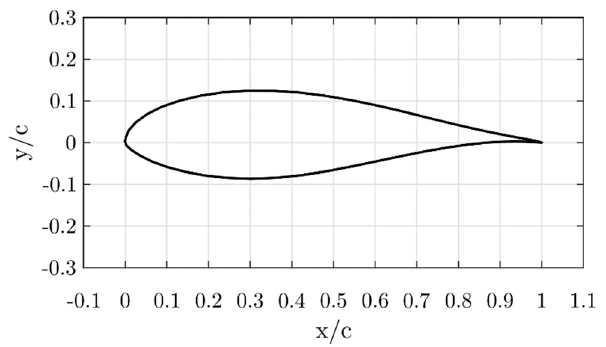
Figure 3. Outline of the UO-17-LDA